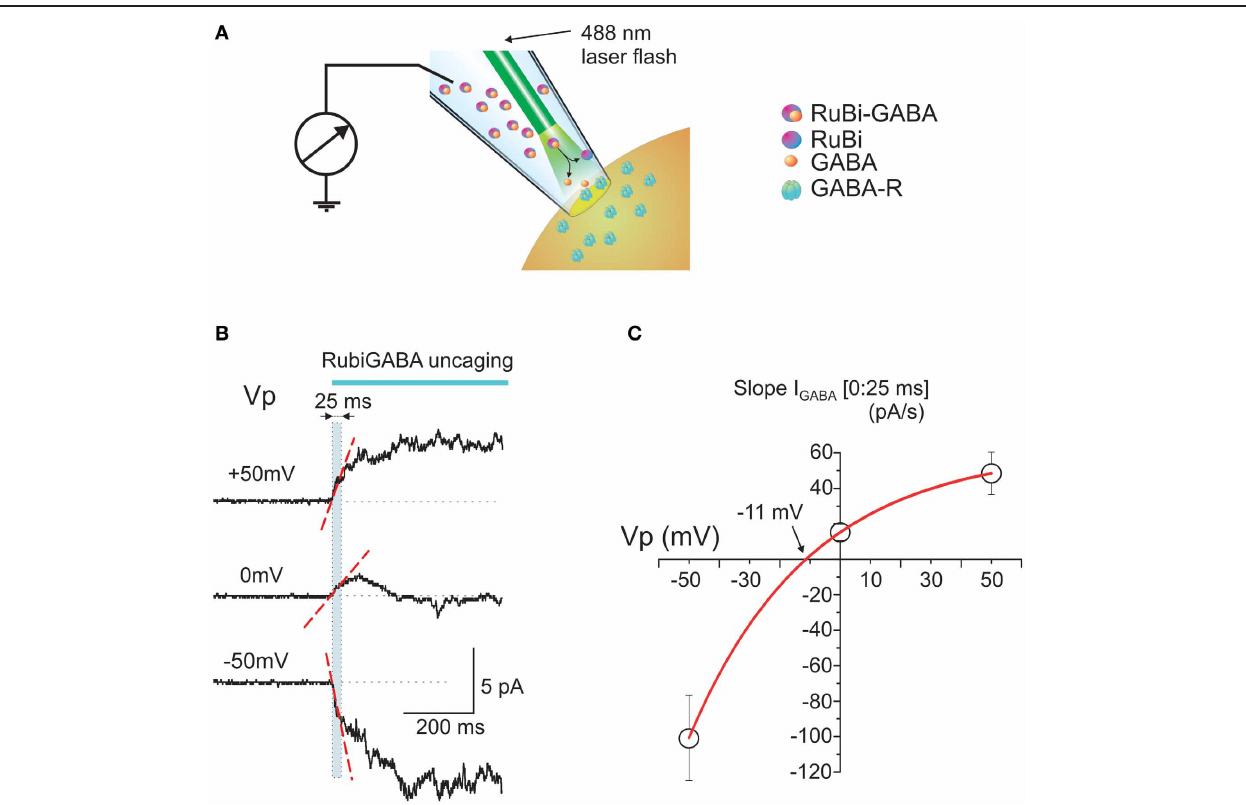
FIGURE 1 | Intrapipette GABA photorelease from RuBi-GABA evokes currents in cell-attached recordings. (A) Scheme of the experimental setup. The patch-pipette is filled with a solution containing RuBi-GABA (20 µ M). An optic fiber is positioned close to the tip of the pipette. Once a gigaseal is formed between the pipette and neuronal membrane, cell-attached recordings enable the recording of currents through the ion channels in the patch of cell membrane attached to the tip of the pipette. After recordings of the baseline activity, a laser pulse is delivered via an optic fiber to uncage GABA from RuBi-GABA and to activate GABA(A) receptor-channels (GABA-Rs). (B) Example traces of the responses evoked by GABA uncaging in cell-attached